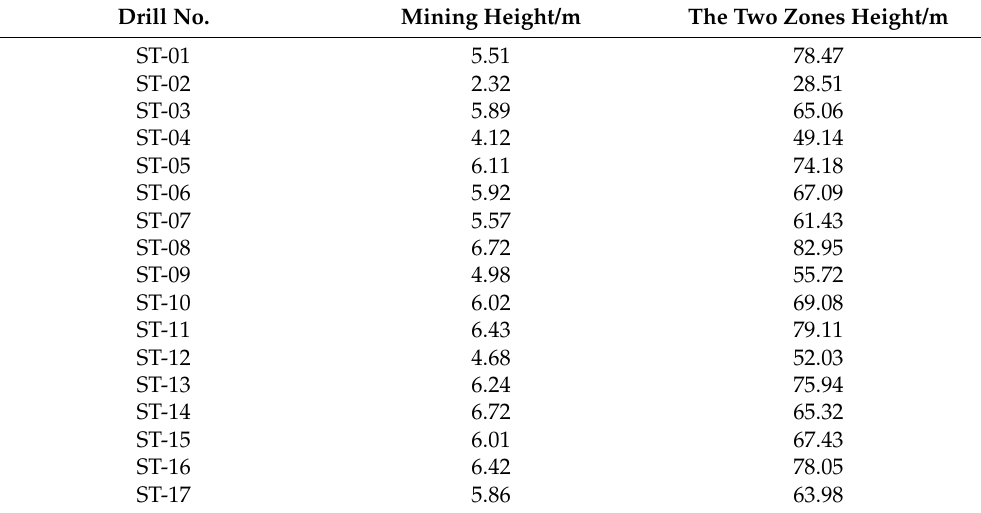
Table 7. Predicted value by PSO-SVM model.